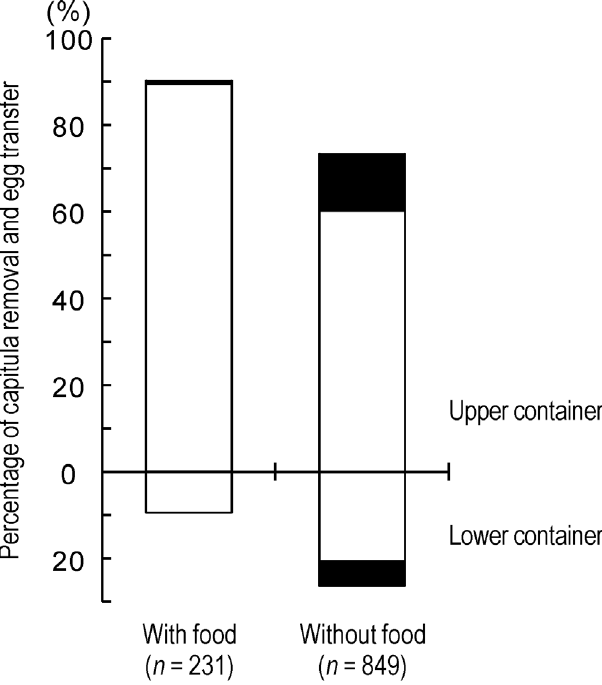
Fig 2 . Percentage of Phraortes illepidus eggs from which capitula were removed by Pristomyrmex punctatus . Closed and open columns respectively show percentages of intact eggs and eggs from which capitula were removed by ants. The percentages of eggs transferred to lower containers are also presented.